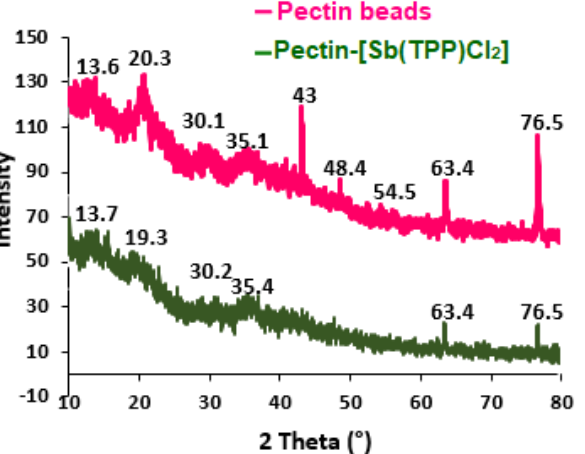
Figure 4. XRD patterns of pectin beads and pectin-[Sb(TPP)Cl 2 ] composite beads